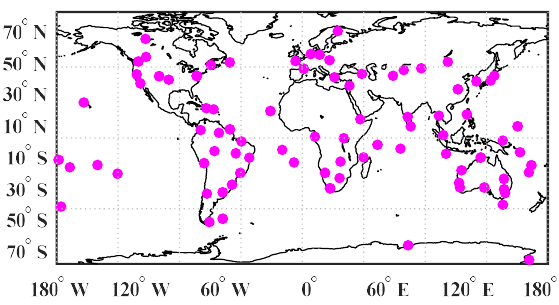
Figure 4. The 87 selected multi-GNSS experiment (MGEX) stations in the network solution. Table 4. Receiver information of the selected MGEX stations.